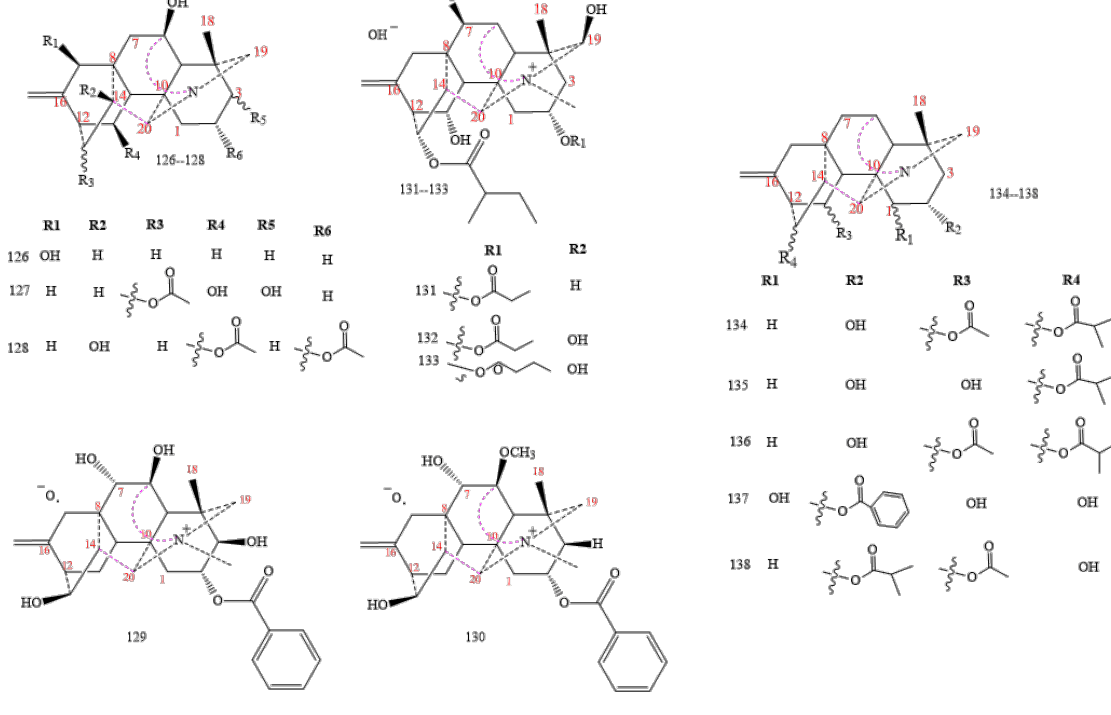
Figure 15. C 20 -hetisine DAs.